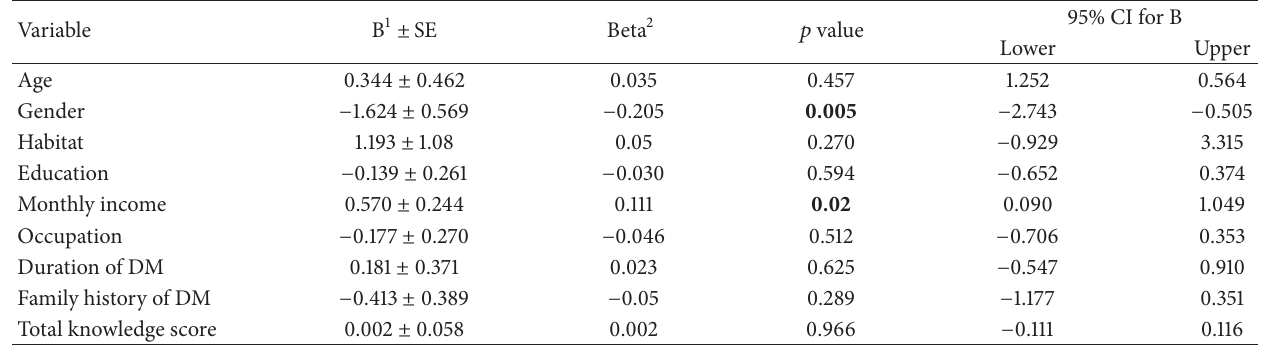
Table 5: Multivariable regression analysis of BMI as a dependent variable with other parameters among patients with type 2 DM ( 𝑛 = 500 ). Variable